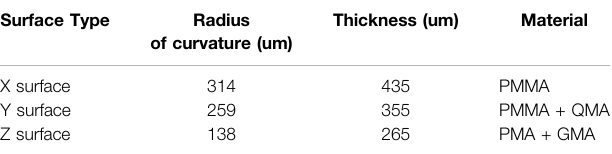
TABLE 2 | Sub-eye initial structure